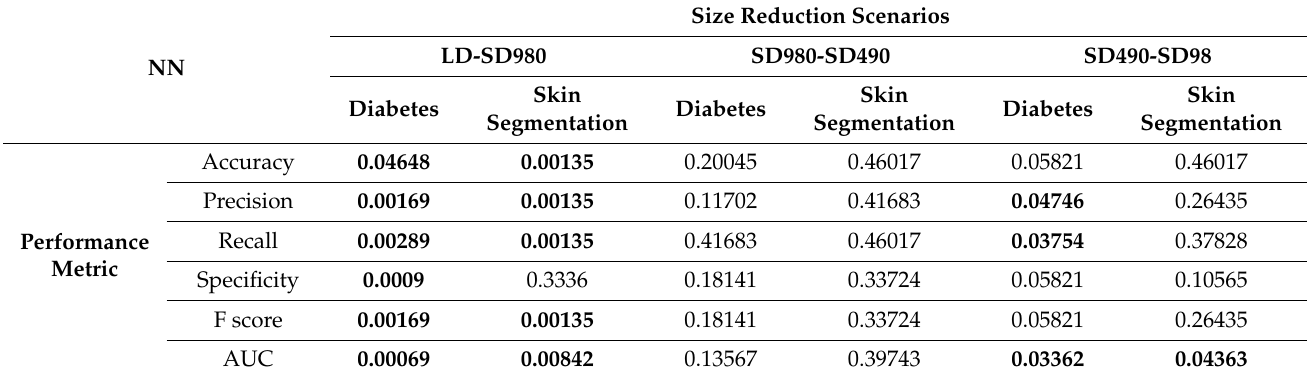
Table A7. p -values for different size reduction scenarios using the NN model; bold values are